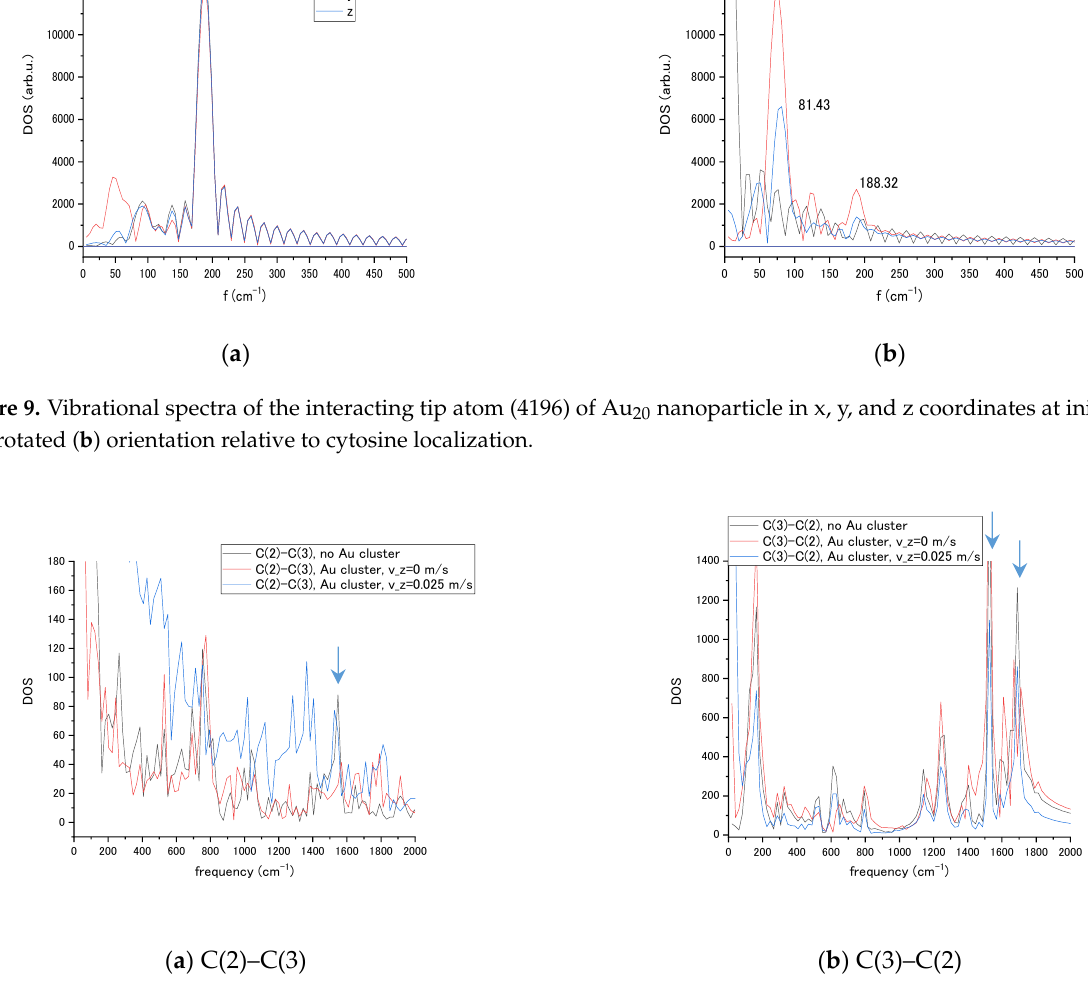
Figure 10. Vibrational spectra of the cytosine bonds ( a ) C(2) – C(3) and ( b ) C(3) – C(2), in the absence and presence of interaction with the Au 20 NP. Transient velocity of the nucleotide was v z = 0.025 m/s.